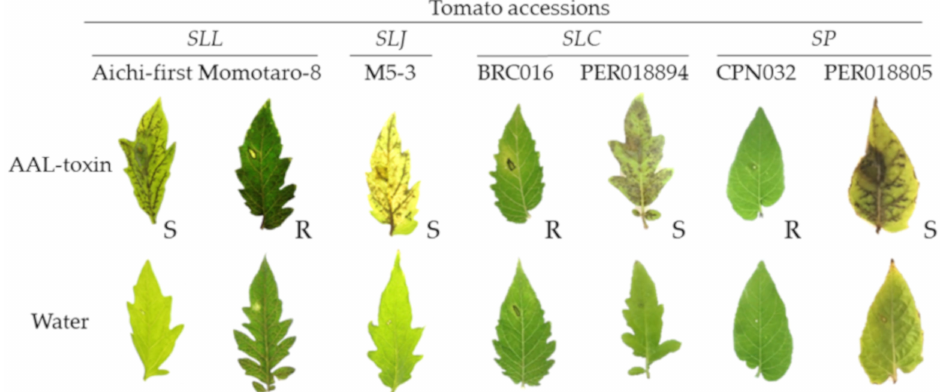
Figure 2. Leaflet bioassay for AAL-toxin from a culture extract of Aal As-27. The abaxial side of each tomato leaflet was wounded and a small piece of filter paper containing either the culture extract or water was placed on the wound and incubated in a humidified chamber (25 ◦ C for 3 days). The necrosis of the leaflet was evaluated, and a susceptible reaction or resistant reaction is indicated with an “S” or “R”, respectively, in the figure. SLL cv. Aichi-first is a representative cultivar with susceptibility to AAL-toxin. SLL cv. Momotaro-8 is a representative cultivar with resistance to AAL-toxin. M5-3 was susceptible to AAL-toxin among two accessions of SLJ . Among 60 accessions of SLC , one accession, PER018894, was susceptible to AAL-toxin, and the others were resistant to AAL-toxin. The reaction of BRC016 is representative of AAL-resistant SLC accessions. Among 37 accessions of SP one accession, PER018805, was susceptible to AAL-toxin, and the others were resistant to AAL-toxin. CPN032 is representative of AAL-resistant SP accessions.